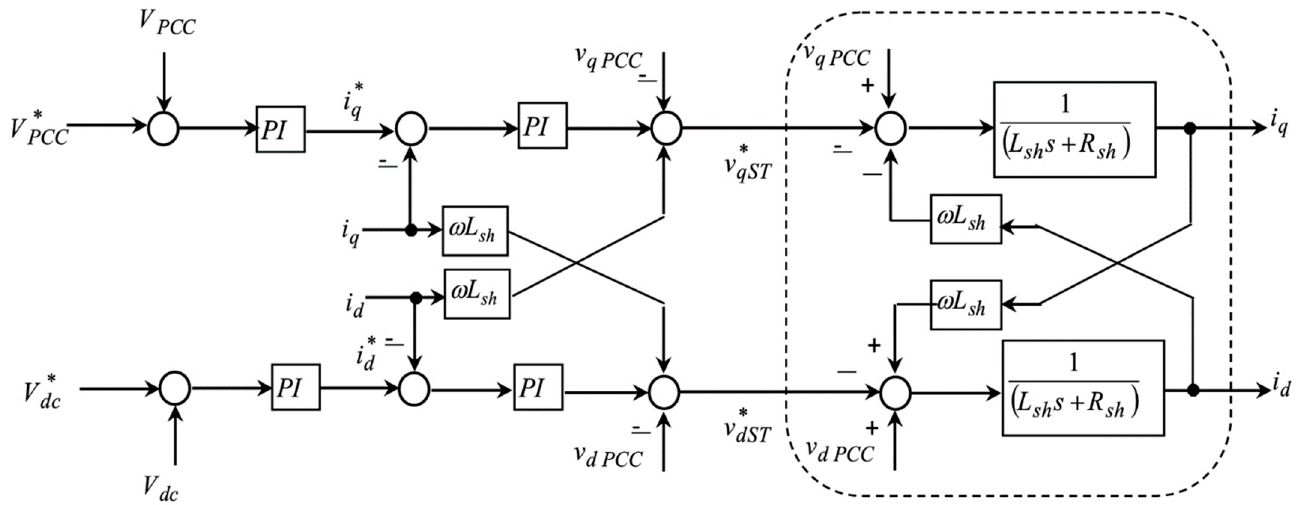
Figure 4. Block diagram for the D-STATCOM control by conventional PI controller.